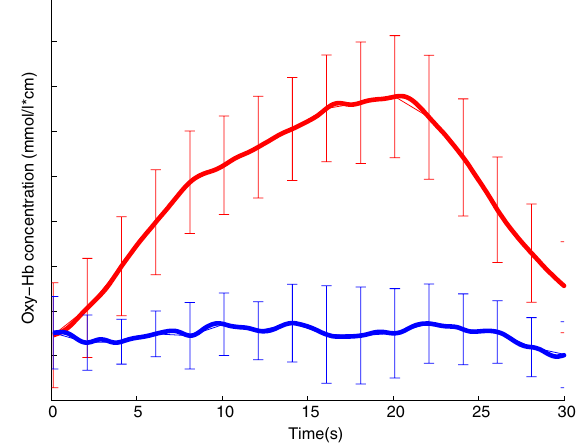
Fig. 3. Oxy-Hb concentration changes of the visual cortex corresponding to task (red curve) and nontask (blue curve) stimulus.